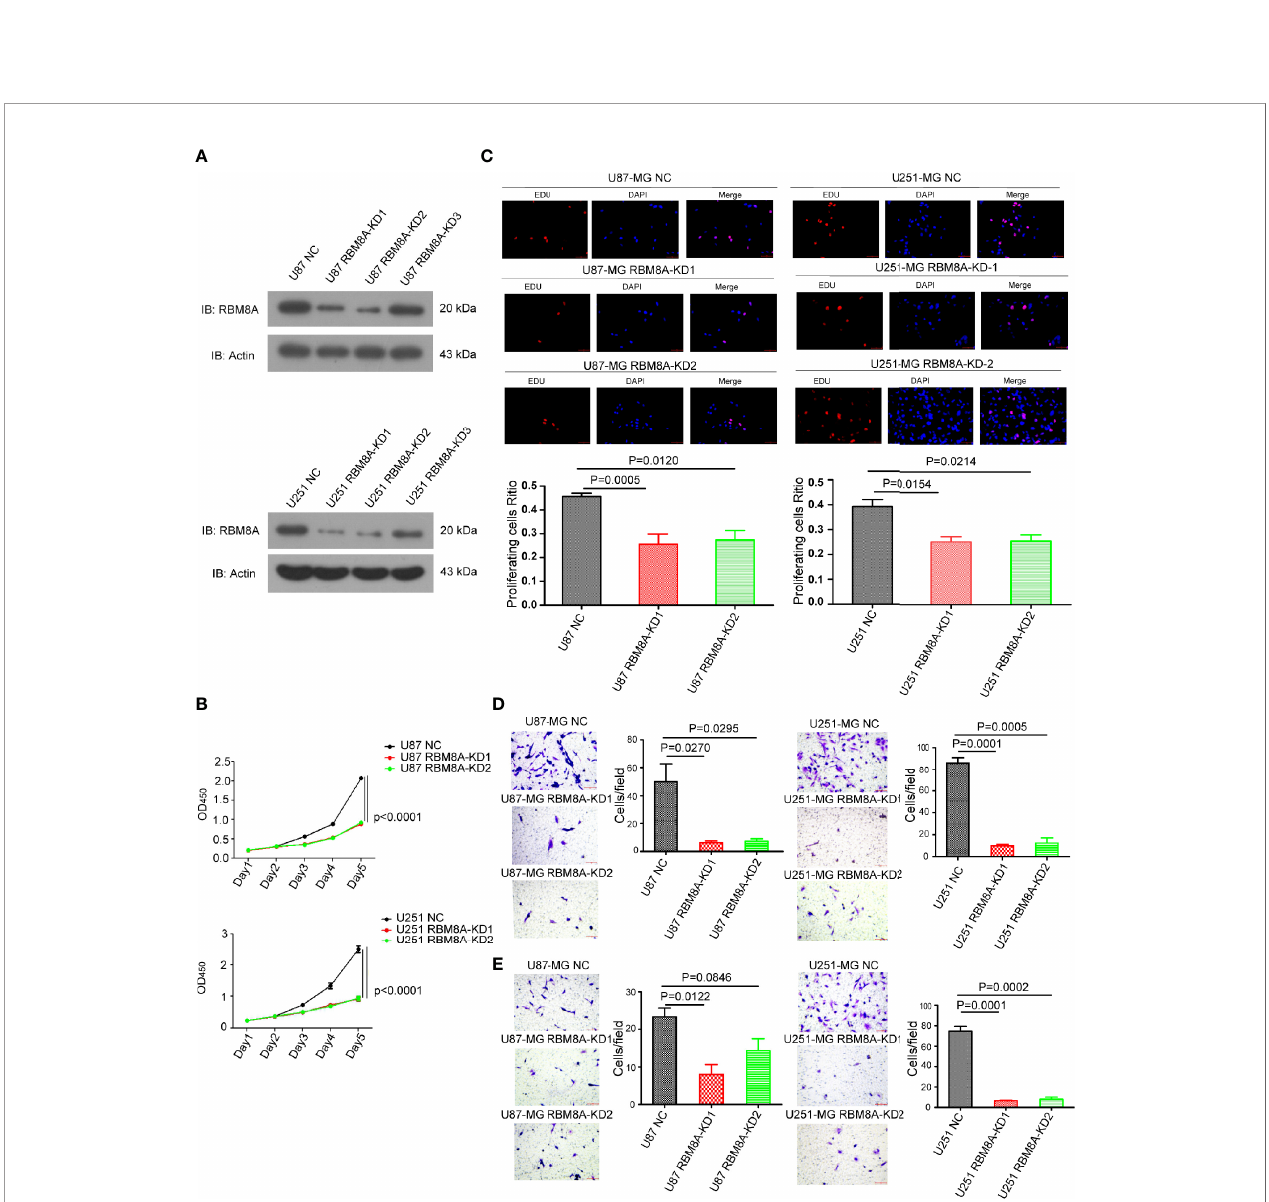
FIGURE 2 | Effects of RBM8A knockdown on proliferation of U87-MG and U251-MG cells and their invasive activity. (A) Expression of RBM8A in U87 or U251-MG cells transformed with control lentivirus (NC) or lentivirus expressing the knockdown-1 (KD1) or knockdown-2 (KD2) small hairpin RNA against the RBM8A gene were determined by western-blotting. (B) Cell proliferation was analyzed using the CCK8 assay as indicated. (C) Cell proliferation was also measured using the EdU assay. Representative fl uorescence micrographs of the different cell cultures are shown. Immunostaining levels are quanti fi ed in the plots below. (D) Transwell analysis of migration, using two-chamber wells without a Matrigel-coated insert. Magni fi cation, 200×. (E) Transwell analysis of invasion, using two-chamber wells with a Matrigel-coated insert. All micrographs are shown at 200× magni fi cation.